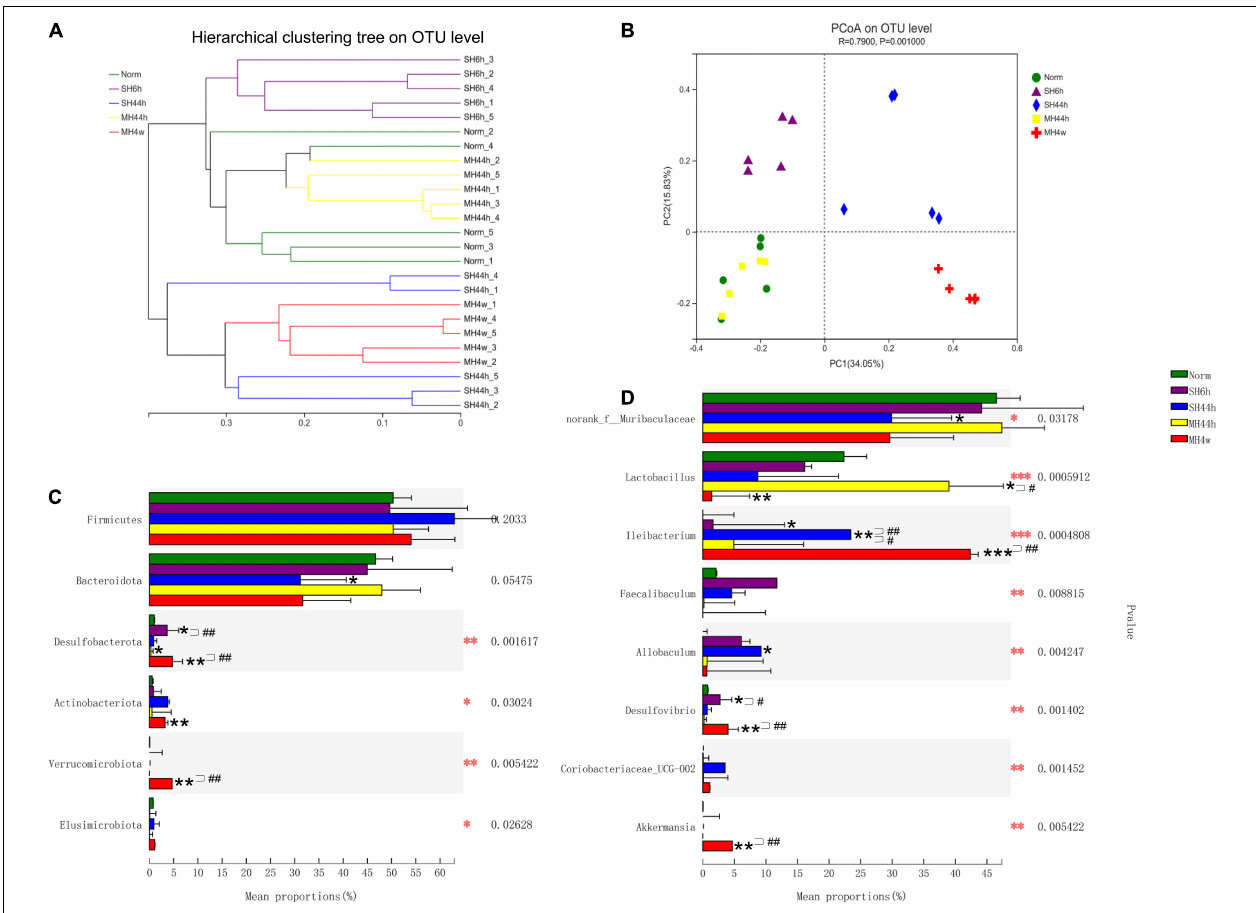
FIGURE 2 | Beta-diversity of gut microbiota of Gansu zokors and relative abundances of microbial taxa. (A) Hierarchical cluster analysis of Bray–Curtis distances generated from taxa tables summarized at the OTU level. (B) Principal Coordinates Analysis represents the differences in the gut microflora among groups. Kruskal–Wallis test was used to examine the differences in the microbial taxa among the groups at the phylum level (C) and genus level (D) . The differences in the bacterial community composition among the different treatments by Kruskal–Wallis test (red asterisks). Black asterisks indicate the comparison between the control and hypoxia treatment groups by student’s t -test. Statistical symbols: * P < 0.05, ** P < 0.01, and *** P < 0.001 between normoxia and hypoxia treatments; # P < 0.05 and ## P < 0.01 between two hypoxic groups under the same oxygen concentration or the same treatment